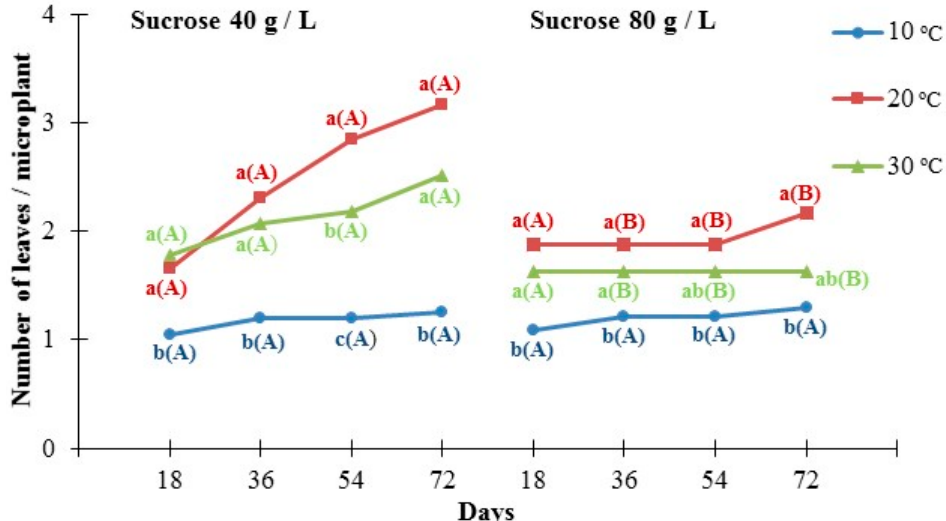
Figure 3. The effect of two different concentrations of sucrose (40 g/L and 80 g/L) at three different temperatures (10 °C, 20 °C, and 30 °C) on the number of leaves per Pancratium maritimum microplant grown in culture media. In each sucrose concentration and each day of measurement, the same lowercase letters indicate non-statistically significant differences among the temperature treatments, according to LSD test ( p ≤ 0.05). In each temperature and each day of measurement, the same uppercase letters in parenthesis indicate no statistically significant differences between sucrose concentrations, according to Student’s t -test ( p ≤ 0.05). Four replicates of five explants for each treatment.